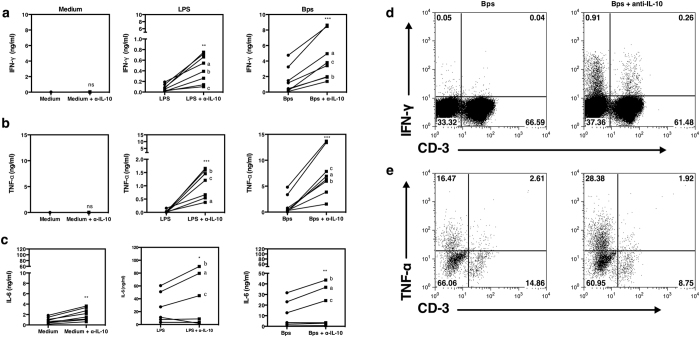
Neutralization of IL-10 increases IFN-γ and TNF-α production by CD3+ versus CD3− cells in response to B. pseudomallei.PBMCs of healthy seropositive individuals (n = 8) were incubated with 10 μg/ml E. coli LPS or killed B. pseudomallei (30:1 ratio) versus medium alone and in the presence or absence of 3 μg/ml of anti-IL-10 mAb. IFN-γ (a), TNF-α (b) and IL-6 (c) production was measured by ELISA from collected supernatant after 48 hours in vitro. Each symbol represents data from an individual. The values from the same individual in the presence or absence of anti-IL-10 mAb condition are joined by a line. To identify the cellular source of cytokines, PBMCs were incubated with killed B. pseudomallei (30:1 ratio) for 20 hours and assayed by flow cytometry for intracellular IFN-γ and TNF-α versus cell surface expression of CD3. A profile of one representative donor, gated initially on lymphocytes (d) and monocytes (e) by FSC/SSC shows the frequency of IFN-γ and TNF-α producing cells respectively. Statistical significance was determined using paired T test; ns, non significant, *p < 0.05, **p < 0.01 and ***p < 0.001. IL-6 statistical significance was determined from 3 out of 6 responding donors.